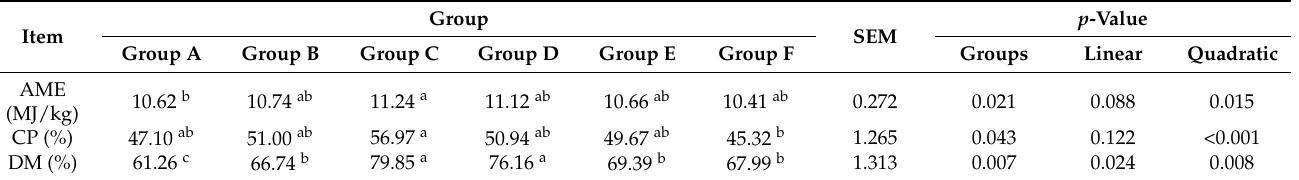
Table 2. Effects of heating time of cottonseed meal on the digestibility of Crude protein(CP), Apparent metabolizable energy(AME), and Dry